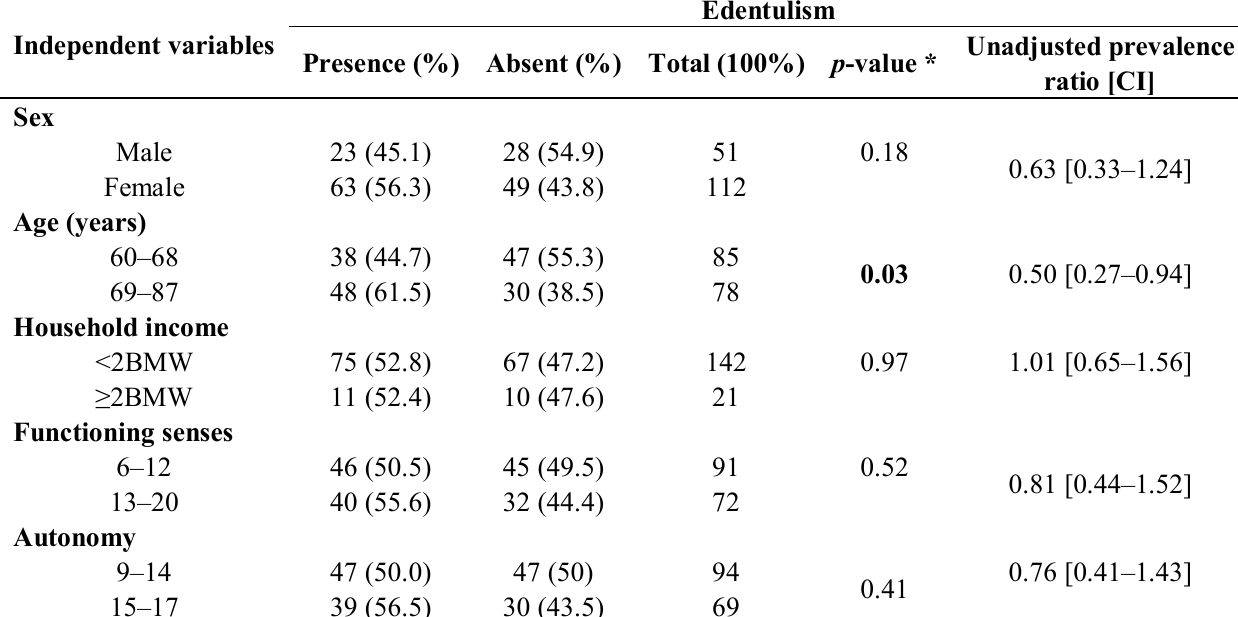
Table 3. Distribution of independent variations in relation to prevalence of edentulism among elderly individuals (n =